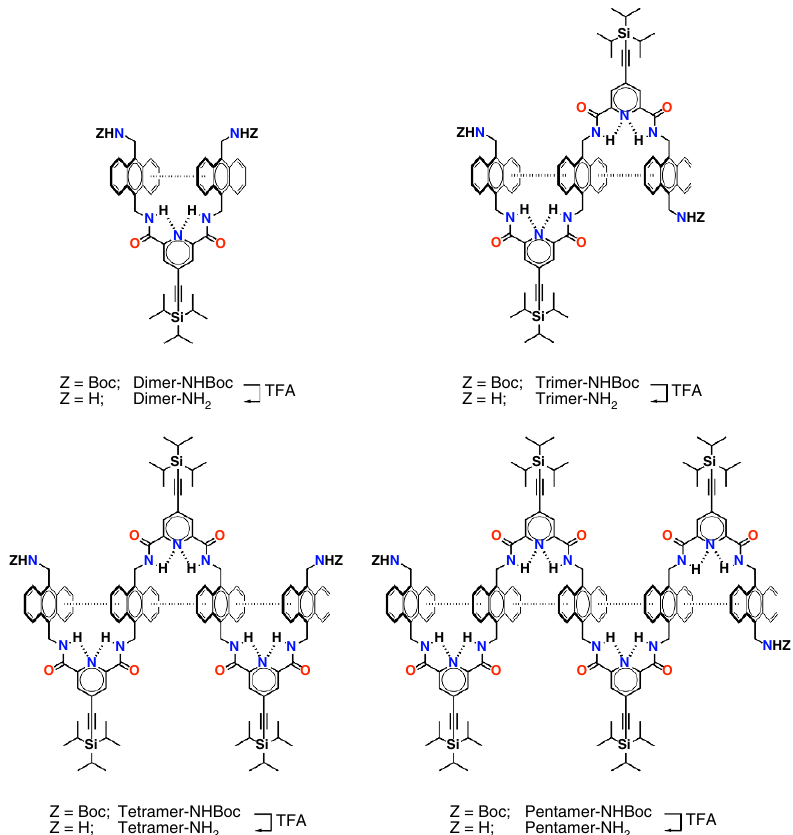
Figure 2 | Chemical structures of the foldamers. Structures of the complete -NHBoc and -NH 2 foldamer series studied in this work: dimer-NHBoc, dimer- NH 2 , trimer-NHBoc, trimer-NH 2 , tetramer-NHBoc, tetramer-NH 2 , pentamer-NHBoc, and pentamer-NH 2 . Arrows indicate the transformation of the -NHBoc series into the -NH 2